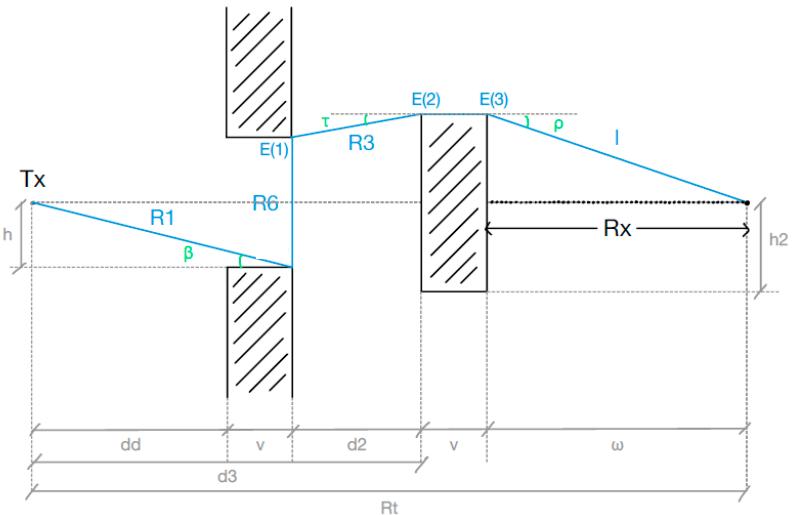
Figure 23. Second quadruple diffraction (Edif_q2) of the second considered NLOS scenario.